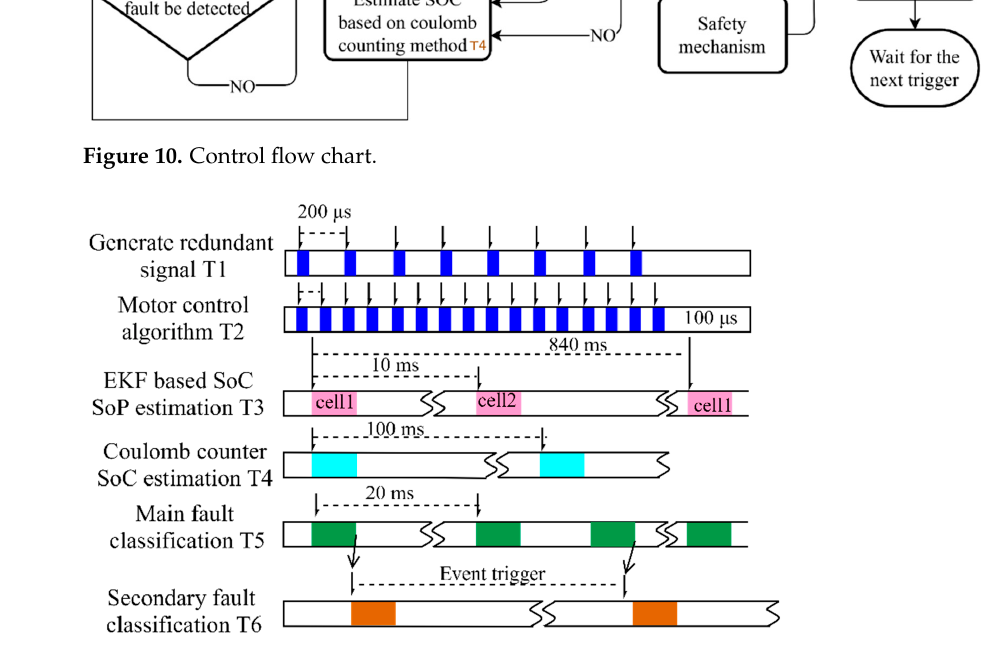
Table 4. Average task execution time and CPU load.